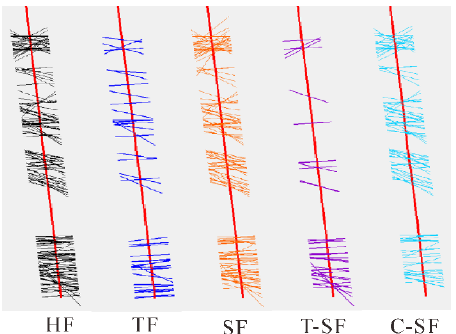
Figure 10. Core fractures along the coring trajectory.